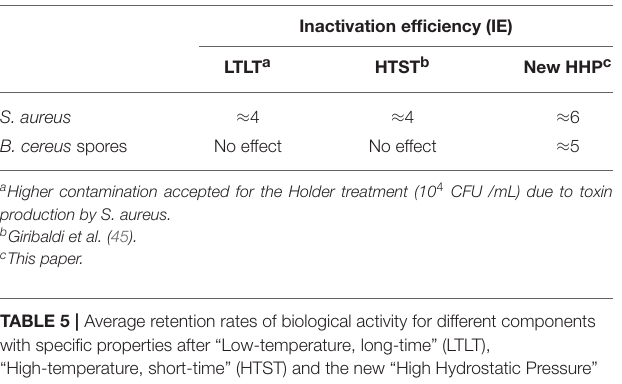
TABLE 4 | Average values of the resulting microbial safety using Staphylococcus aureus (Gram-Positive Bacterium) and Bacillus cereus (Sporulated Bacterium) as contamination references.